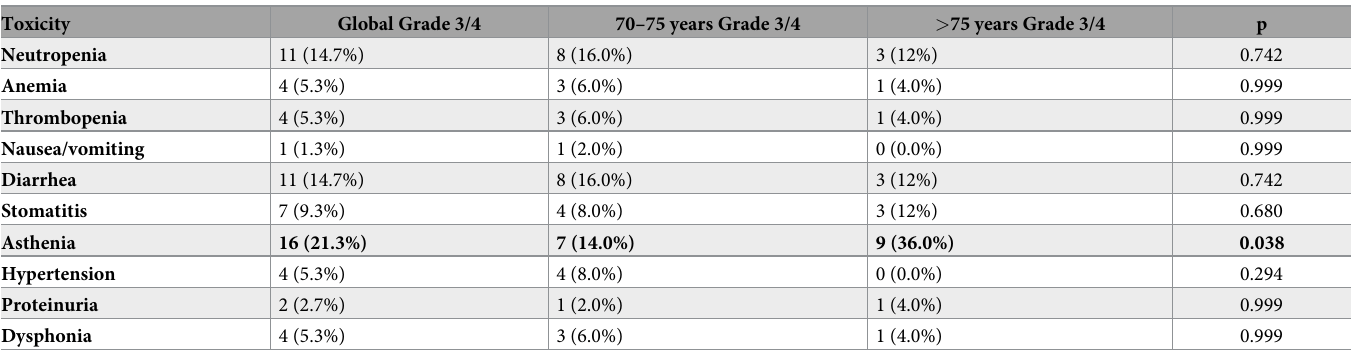
Table 8. Grade 3/4 adverse events according to age